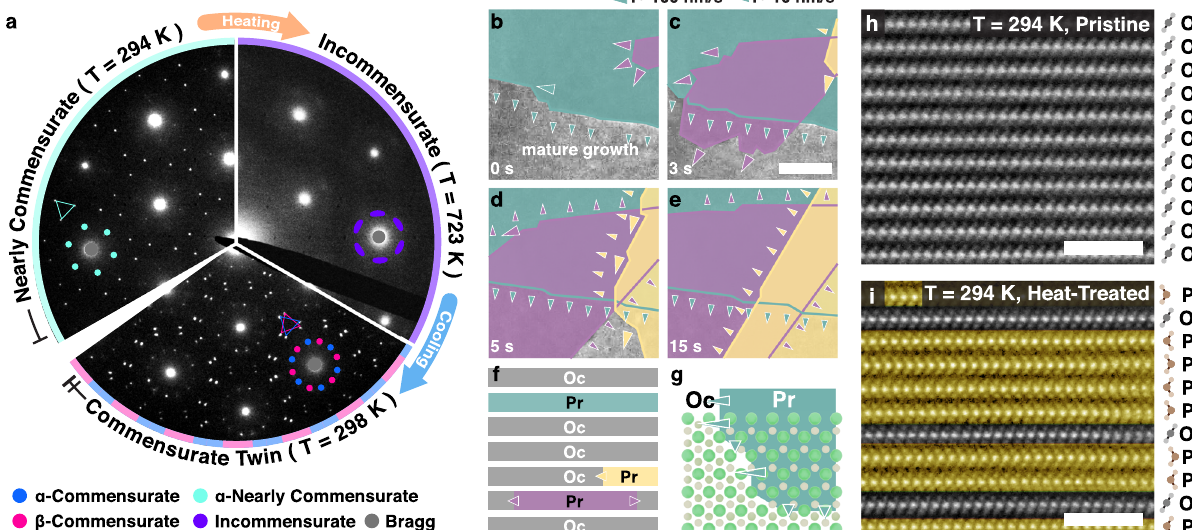
Fig. 2 Polytype isolation forms 2D CDW layers. a Pristine 1T-TaS 2 at room temperature hosts NC-CDW (left). Upon heating the NC phase gives way to IC-CDW (right) at ~350 K; the transition is normally reversible. Remarkably, heating above ~620 K then cooling stabilizes tC-CDW (bottom). SAED patterns were formed from a 500 nm aperture b – e In-situ TEM reveals layer-by-layer octahedral to prismatic polytypic transformations during heat treatment. Multiple polytypic domains (denoted green, purple, and yellow) nucleate and grow simultaneously without interaction (See Supplementary Movie 1). Scale bar is 350 nm. f Schematic cross-section of TaS 2 during layer-by-layer polytypic transition. g Fast and slow transitions occur along h 1010 i and h 1120 i directions respectively. h , i Atomic resolution cross-sectional HAADF-STEM of h pristine and i heat-treated TaS x Se 2 − x con fi rms polytypic transformation. After treatment, prismatic (Pr) layers encapsulate monolayers of octahedral (Oc) layers. Scale bar is 2 nm. A selenium doped sample was imaged to enhance chalcogen